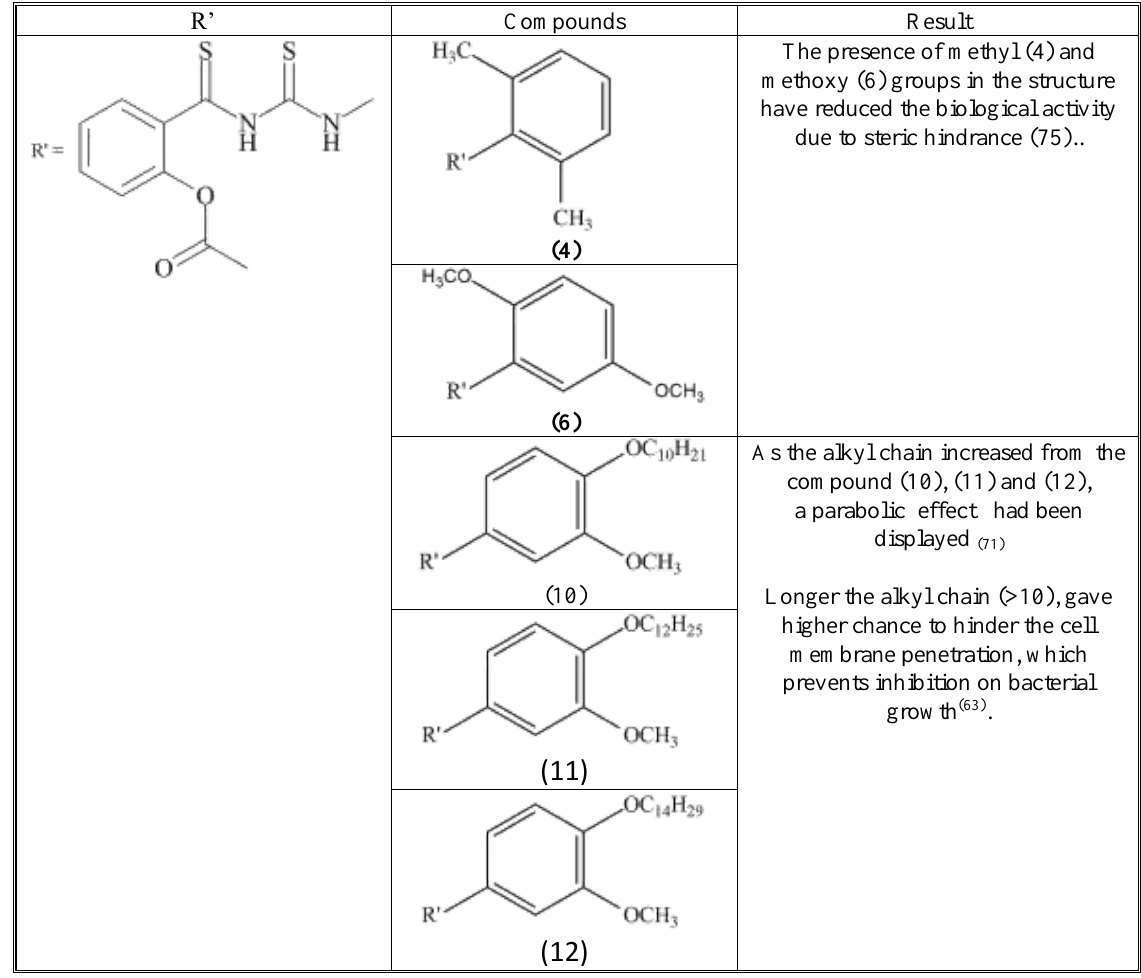
Table 1. Results on the alkylated amine on aspirin-thiourea based on their